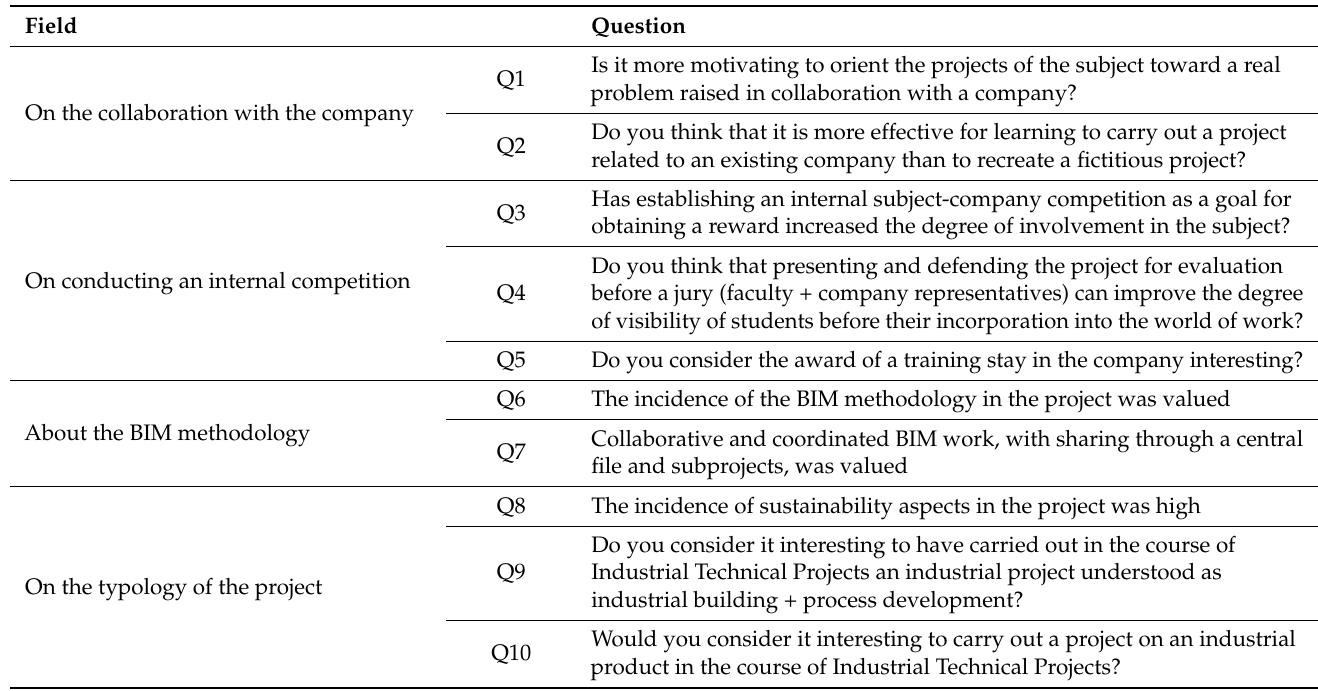
Table 6. Survey conducted with students on the project, BIM, and university-company collaboration.